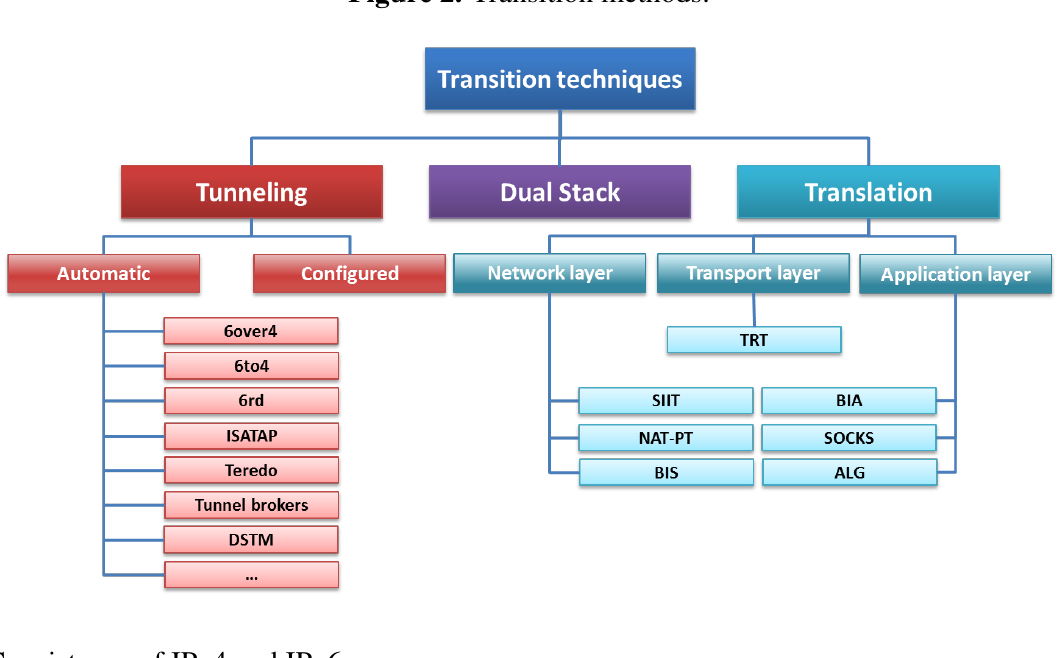
Figure 2. Transition